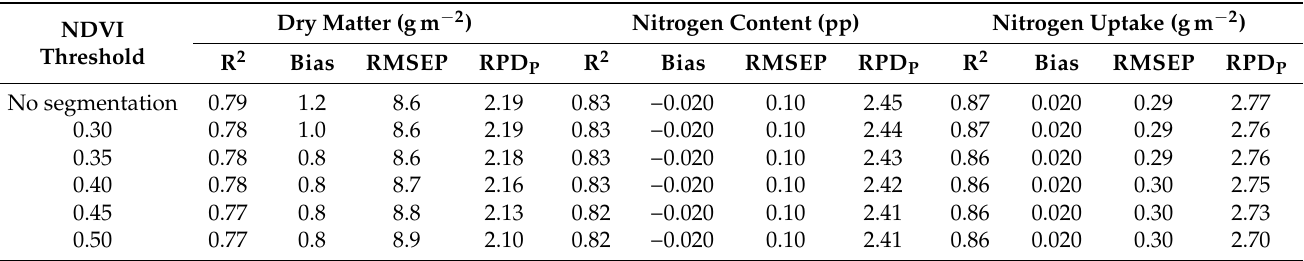
Table 5. Sensitivity of model prediction quality to the choice of soil–vegetation pixel segmentation threshold. Metrics of the most accurate models are presented. These were Gaussian process regression models with the squared exponential kernel trained to raw push-broom hyperspectral reflectance data augmented with apparent soil electrical conductivity measurements. Groups of the columns correspond to the individual estimated crop parameters. The units of bias and RMSEP values are given in parentheses. The rows compare the model